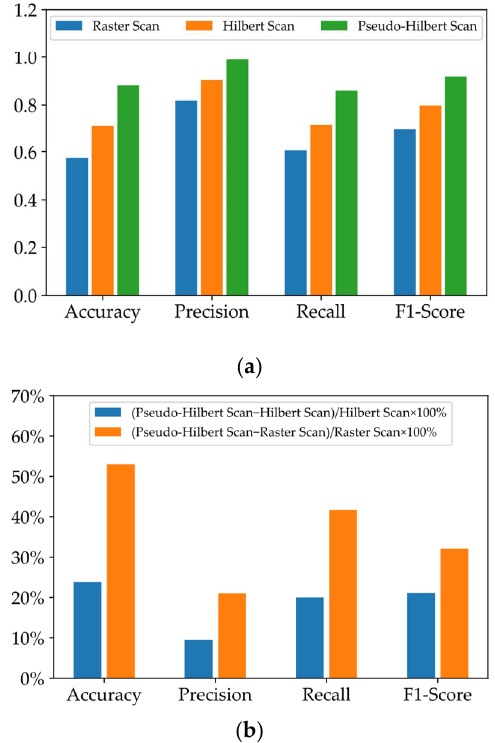
Figure 10. Results of ( a ) four indicators for evaluating network performance under different scanning methods and ( b ) performance superiority of pseudo-Hilbert scan.